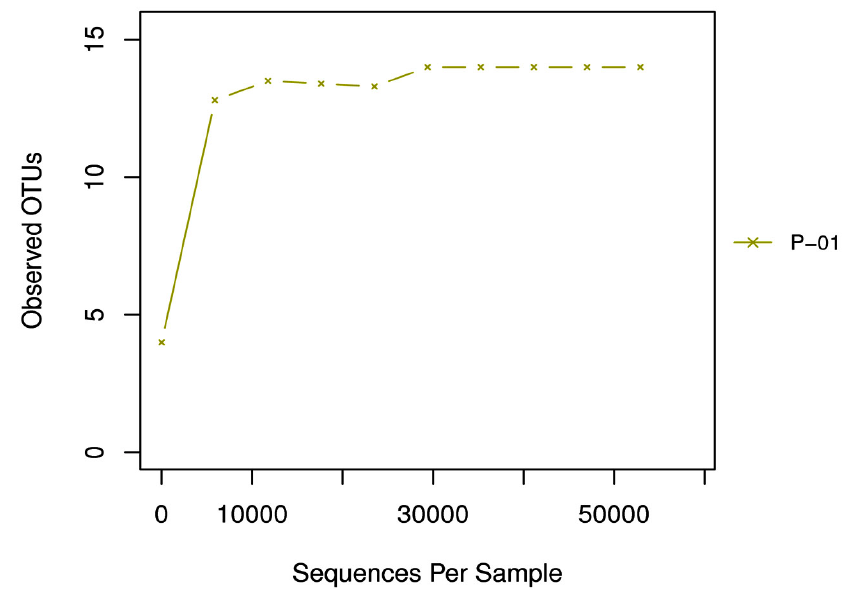
Graph 2. Rarefaction curve: The X axis is the valid sequences extracted, and Y axis is the number of OTUs. The number of OUTs increases with the increase of extracted sequence count until reaching a plateau, which indicates the number of detected OTUs will not increase with the amount of extracted sequences and reflects the reasonable sequence